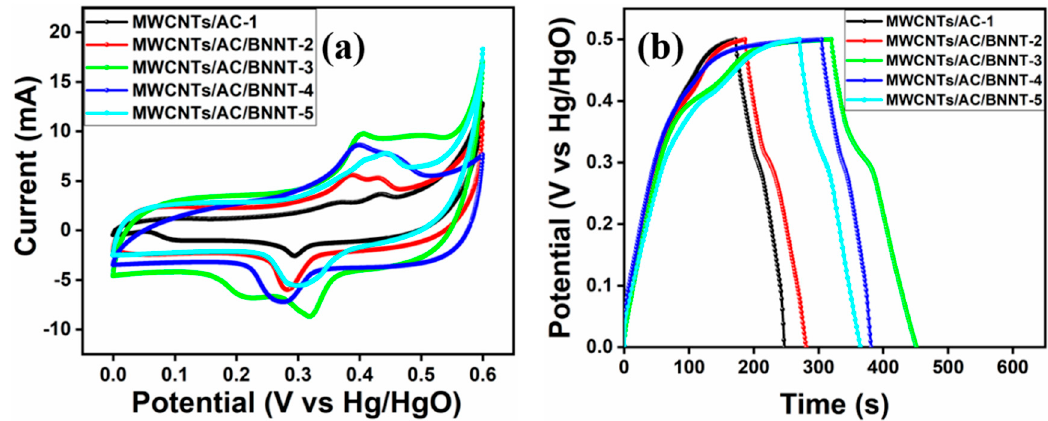
Figure 5. Electrochemical characterizations of printed the MWCNTs/AC/BNNTs ternary composite material with different contents of BNNT material: ( a ) cyclic-voltammetry (CV) response measured at a scan rate of 30 mV s − 1 ; and ( b ) galvanostatic charging–discharging (GCD) curves measured at a current density of 1 A g − 1